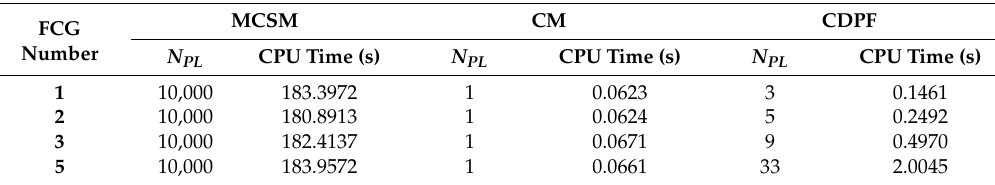
Table 4. CPU time and calculation number N PL of DPF.